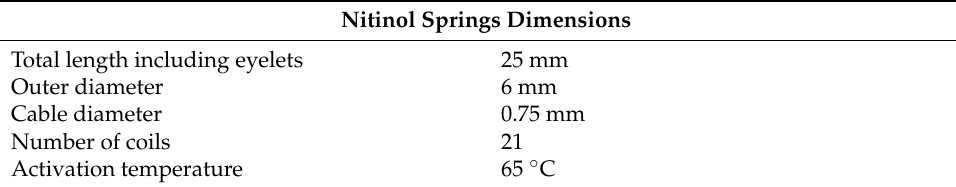
Table 1. Nitinol springs’ characteristics.